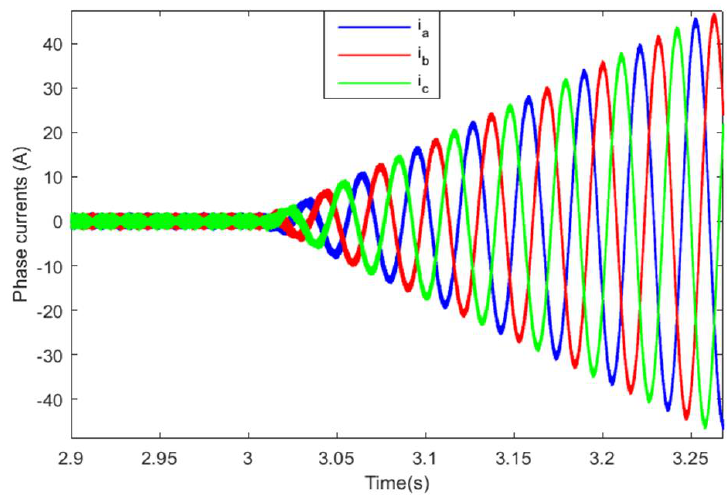
Figure 26. Front PMSM currents with the LBT function.